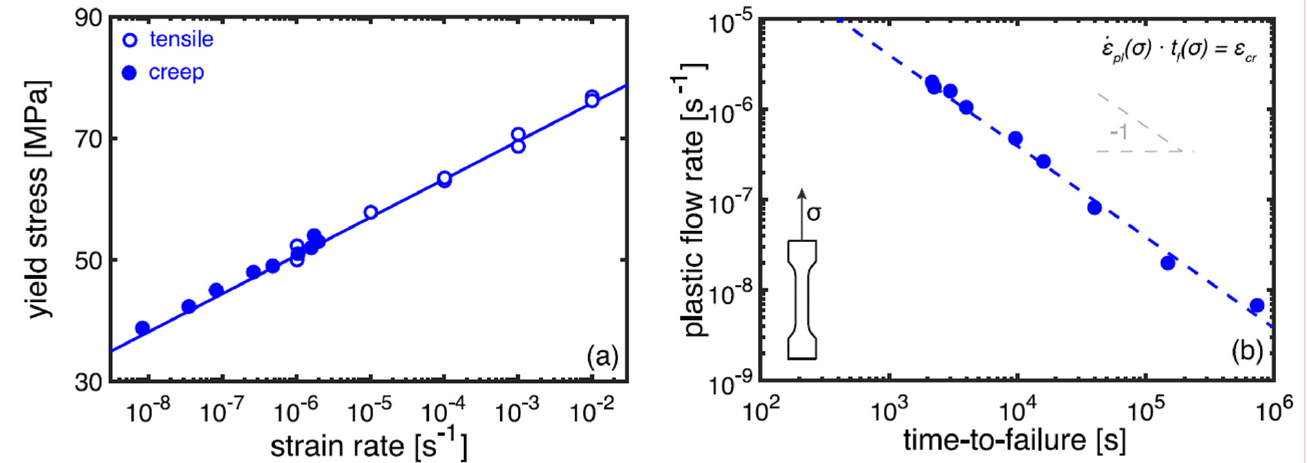
Figure 9. Strain rate dependencies of the yield stress in tensile tests and applied stress in creep tests ( a ) and a correlation between the plastic flow rate and time-to-failure according to Equation (24) ( b ) for glass fibre reinforced isostatic polypropylene composites